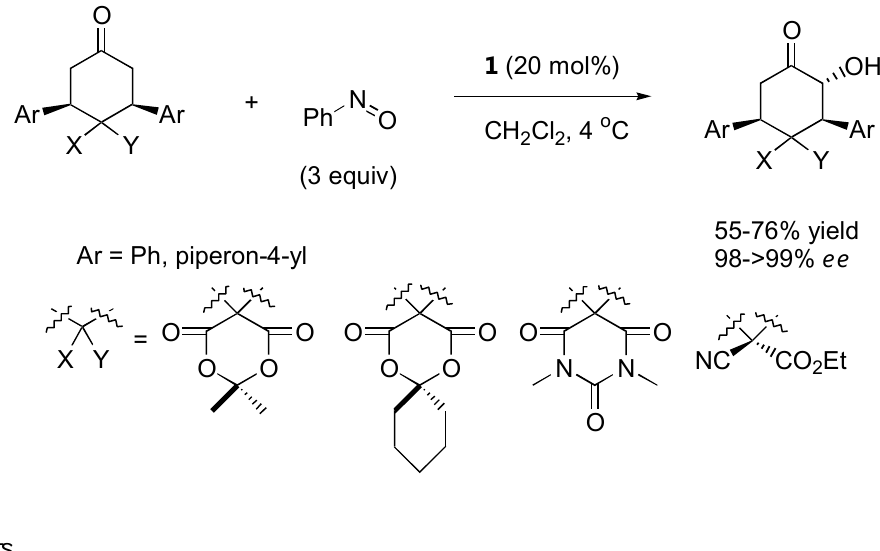
Figure 17. L -Proline ( 1 )-catalyzed  -aminoxylation of spirocyclic ketones followed by concomitant N-O bond heterolysis [70].